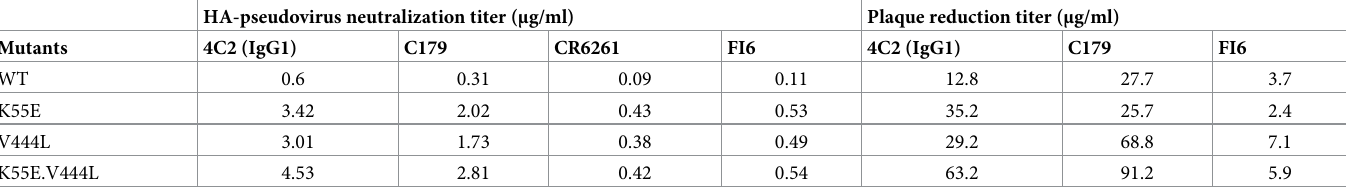
Table 3. Stem MAb neutralization against A/Puerto Rico/8/1934 escape mutants. HA-pseudovirus neutralization titer ( μ